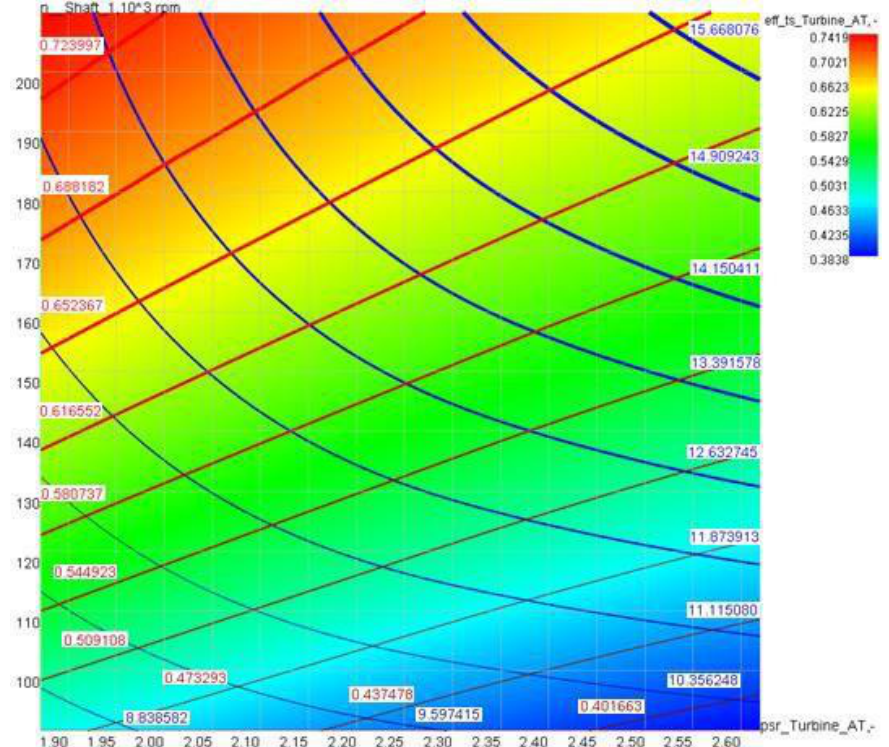
Figure 16. Prismatic Range 1 turbine map ( y -axis: shaft speed in rpm (1000 s); x -axis: turbine pressure ratio). The legend at the top right-hand side indicates the range of total-to-static turbine efficiency.